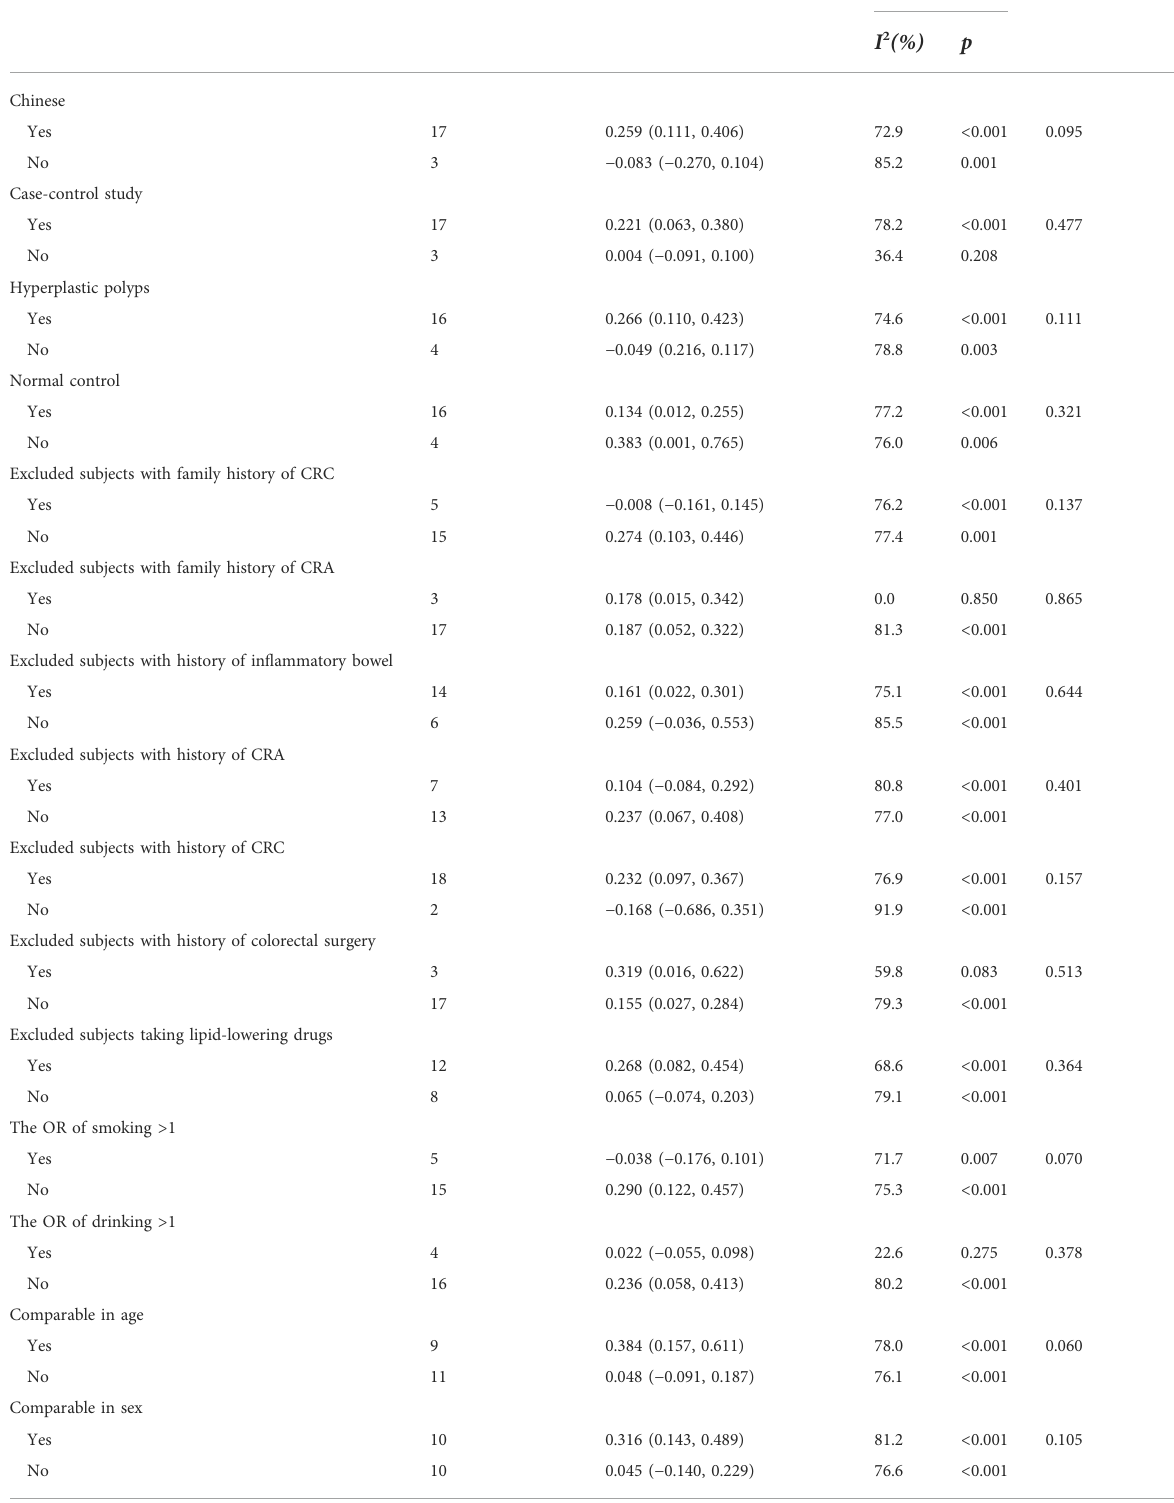
TABLE 4 Heterogeneity source analyses for mean difference of